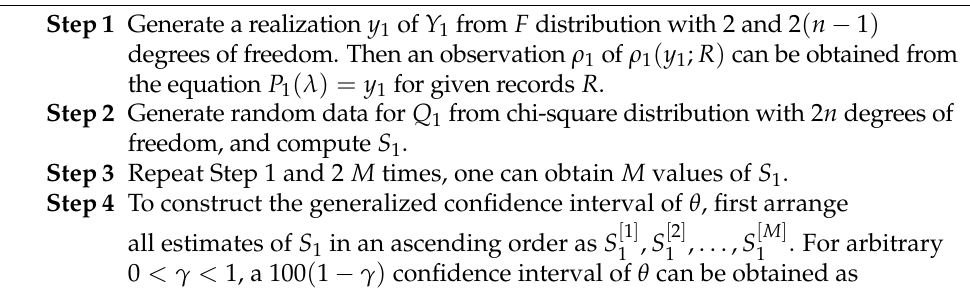
Algorithm 1: FGCI for parameter θ